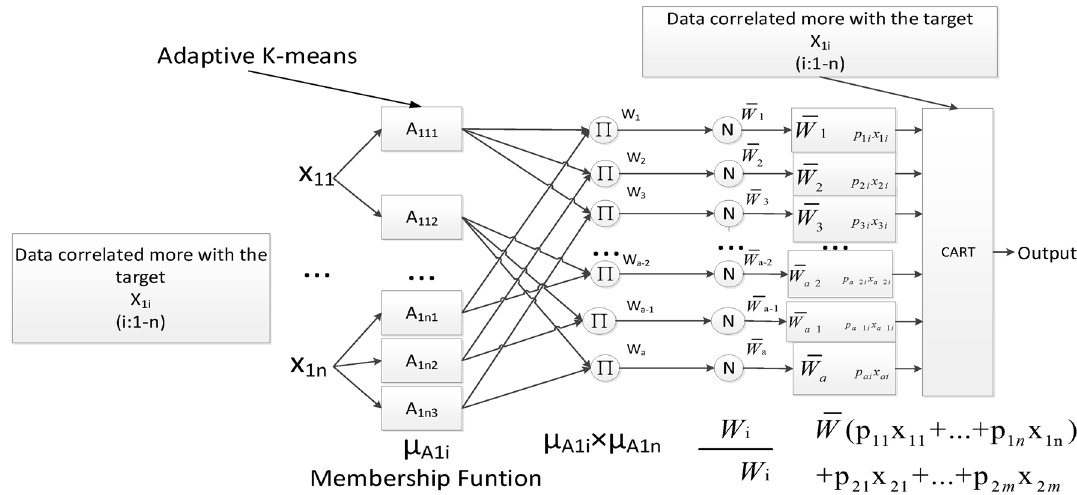
Figure 5. Modified ANFIS for generating weighted